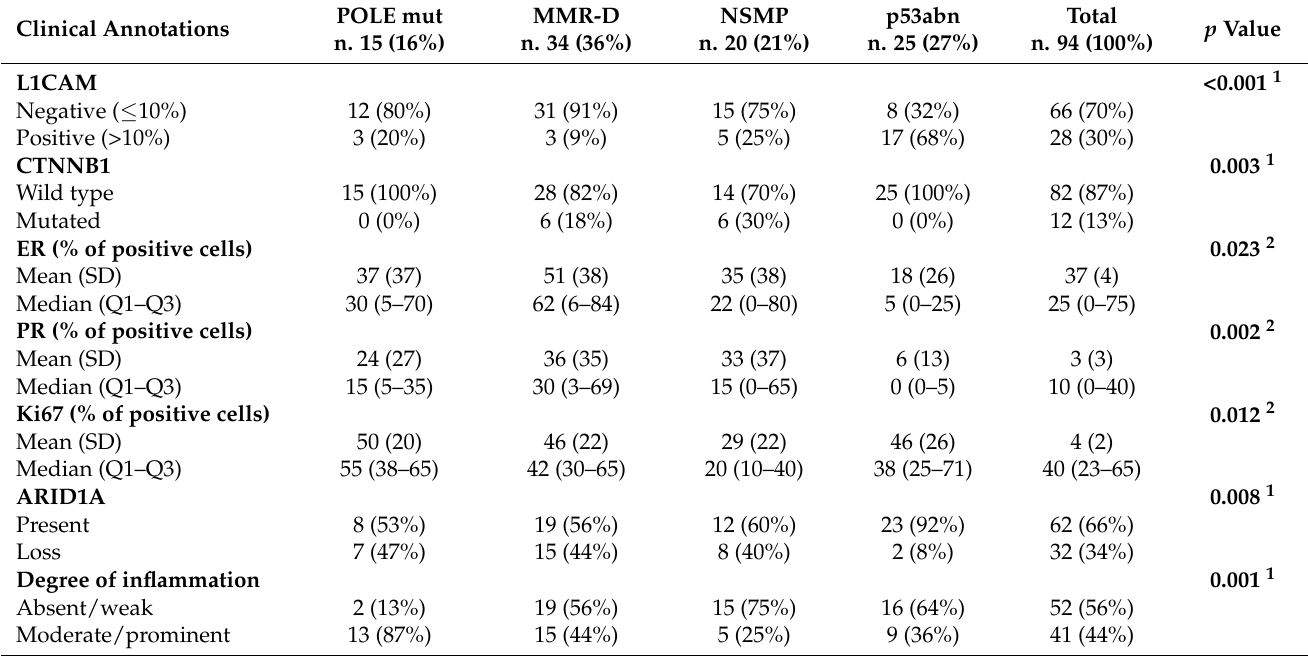
Table 3. Association between molecular subtypes and additional biomarkers of the Brescia Cohort. Clinical